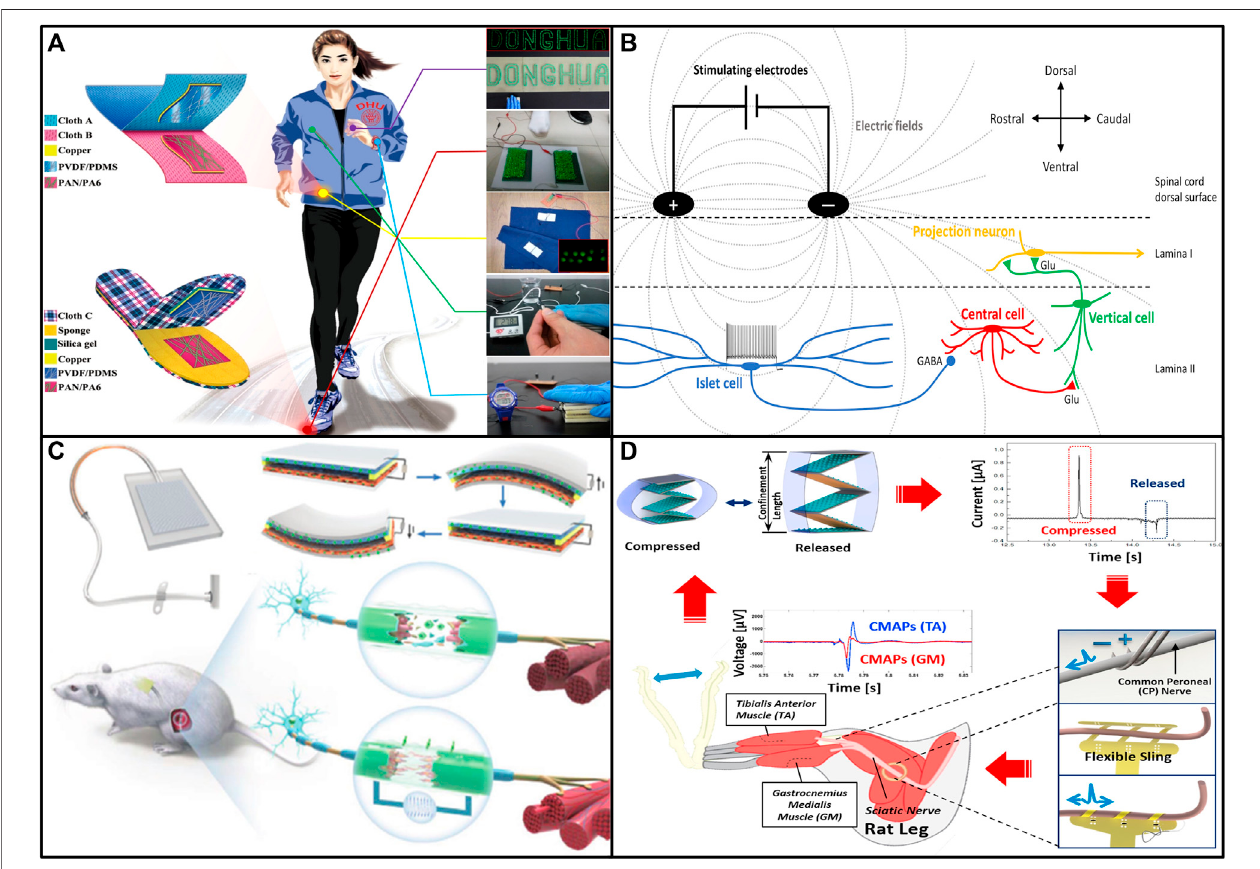
FIGURE 2 | (A) Demonstration of the NM-TENG to harvest various biomechanical energy from human body. (B) Schematic illustrating proposed mechanism of action ofspinal cord stimulation forpain. (C) Design and working principle ofthe ISR-NES system. (D) Schematic diagram ofthe conceptualsystem using fl exible neural interfaces and TENGs (Lee et al., 2017; Li et al., 2017; Jensen and Brownstone, 2019; Zhou et al., 2022).